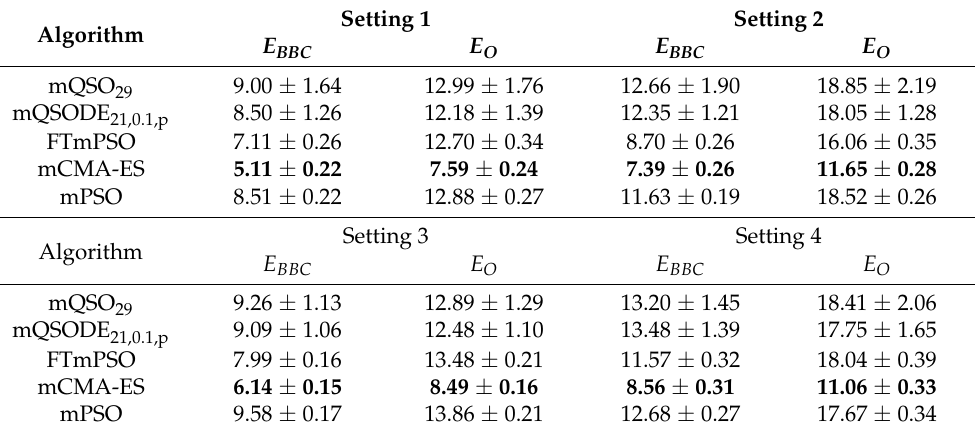
Table 8. Comparison of mQSO and mQSODE with alternative approaches from [10].